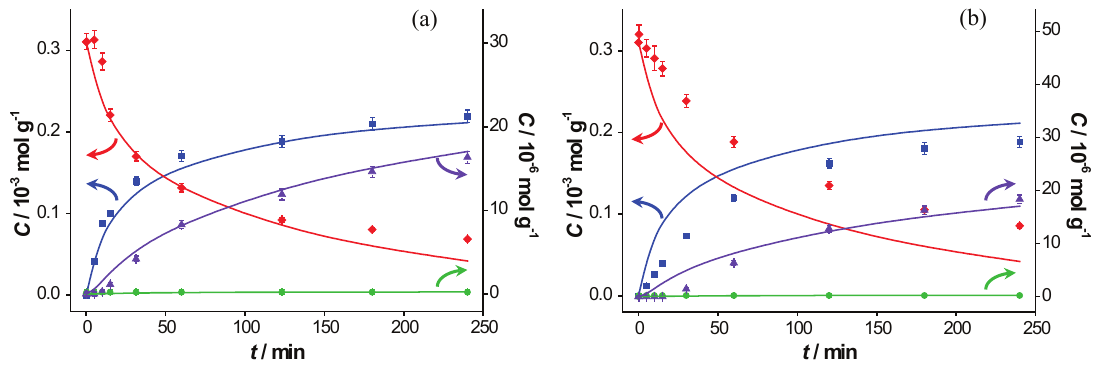
CO , C = 3.0 × 10 − 4 mol·g − 1 , in 80 mL of toluene, 2 3 BnOH, t=0